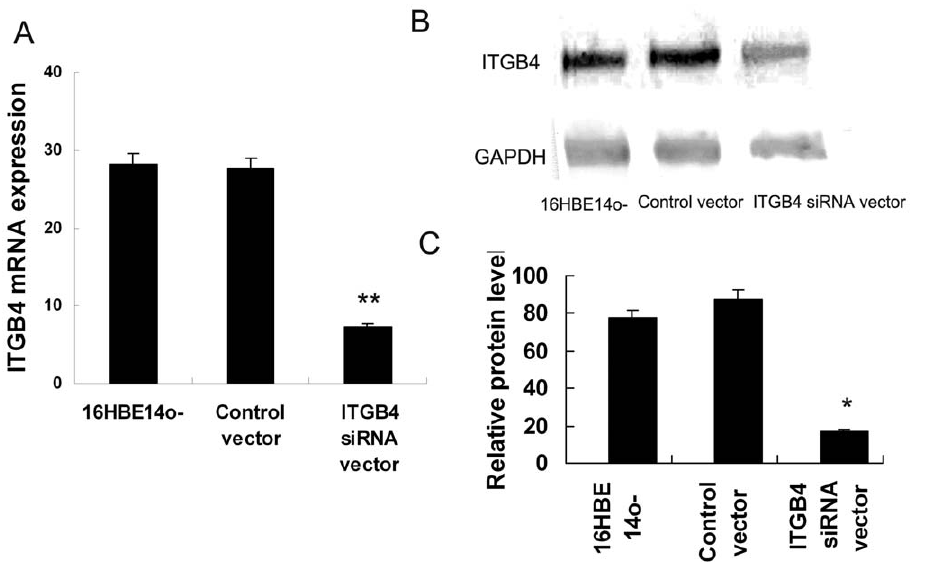
Figure 1. Silencing efficiency was detected after ITGB4 siRNA-containing lentivirus was transfected. The effective ITGB4 siRNA lentivirus vector and control nonsense siRNA lentivirus vector were prepared and transfected into 16HBE14o- cells. (A) 72 h after lentivirus vector transfection, ITGB4 mRNA expression was detected by real time PCR. (B) Western blot analysis was used to detect ITGB4 protein expression 72 h after tansfection. (C) Quantification of western blot normalized to the level of GAPDH in Figure 1A.